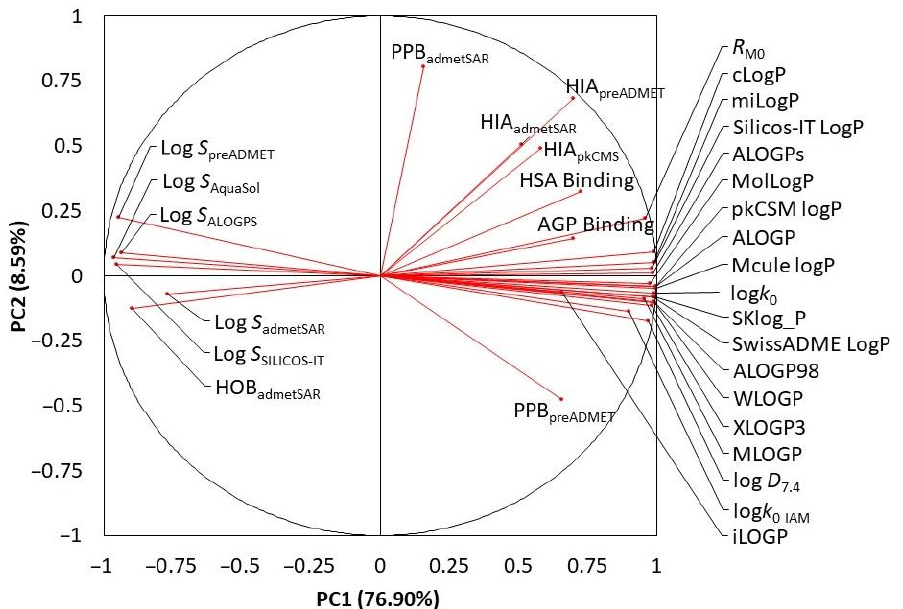
Figure 2. Results of PCA analysis reflecting correlation between predicted and experimentally observed values.